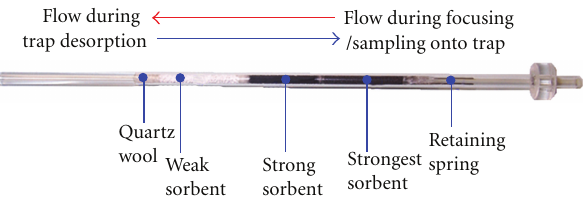
FIGURE 1: Multibed focusing trap (Markes International Ltd, UK), showing weak sorbents at the left for trapping semivolatile organic compounds and strong sorbents at the right for trapping very volatile organic compounds.